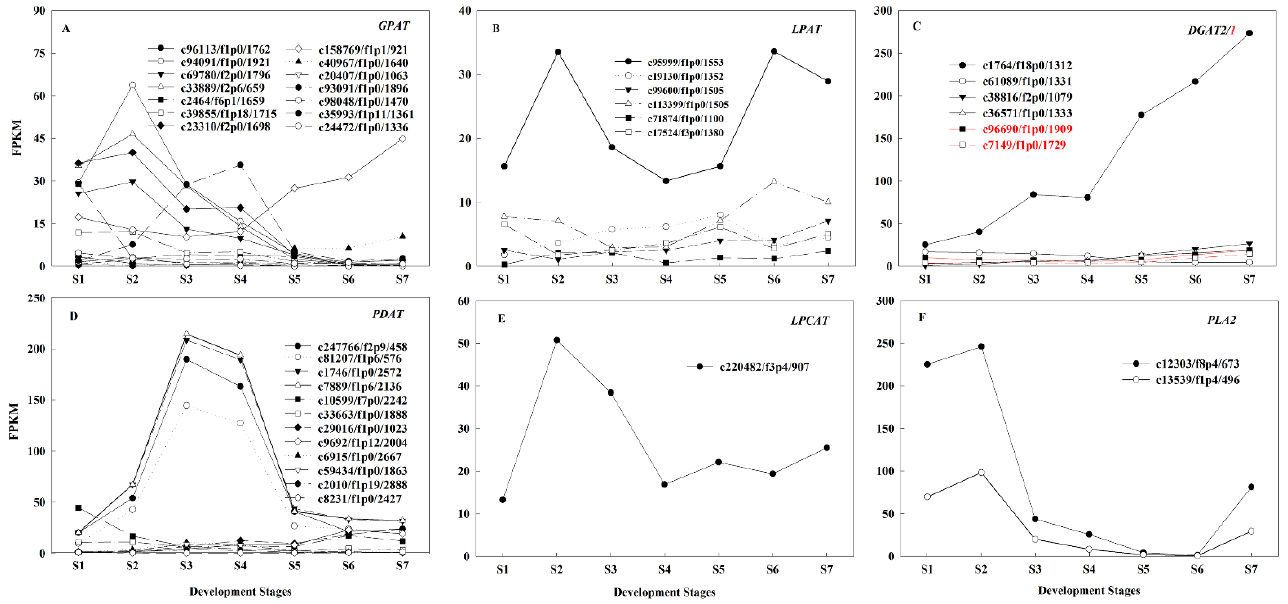
Figure 5. Analysis of gene expression related to triacylglycerols (TAG) biosynthesis pathway. Gene expression patterns of GPAT ( A ), LPAT ( B ), DGAT ( C ), PDAT ( D ), LPCAT ( E ), and PLA2 ( F ) during A. sphaerocephala seed development. Note: The red in ( C ) indicates DGAT1.